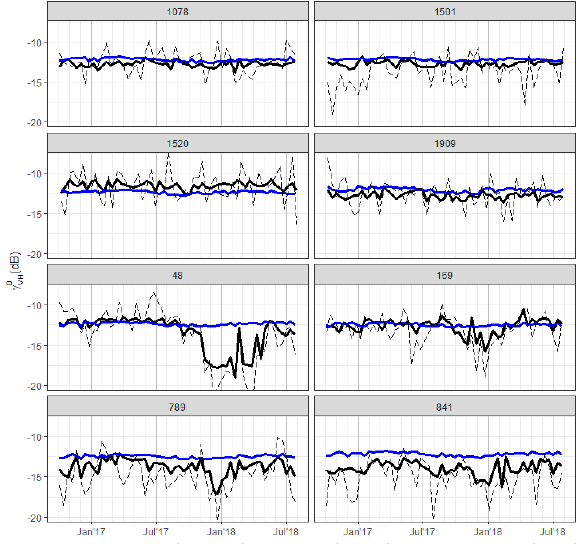
Figure 8: Original (dashed), filtered (black) and predicted (blue) γ 0 VH values on 8 random locations. Upper 2 row time-series correspond to intact forest areas. Lower 2 row time-series come from deforested